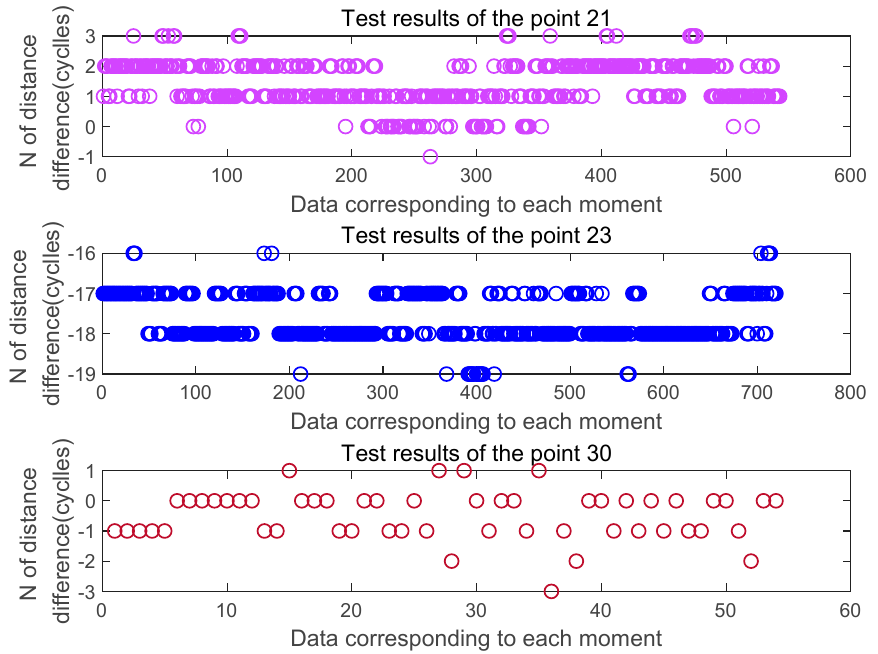
ff erence N at the three feature points in the first set of Figure 12. Estimated distance difference N at the three feature points in the first set of tests. Figure 12. Estimated distance di